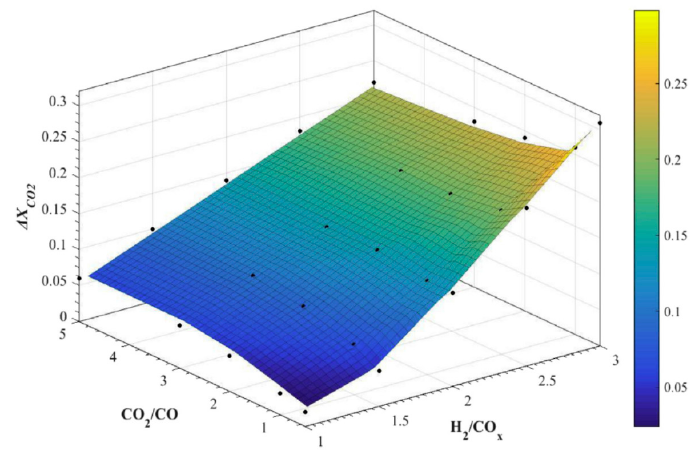
Figure 14. CO 2 conversion enhancement varying the inlet feedstock composition for Dimethyl ether (DME) production. Reproduced from [73] with the permission of Elsevier.